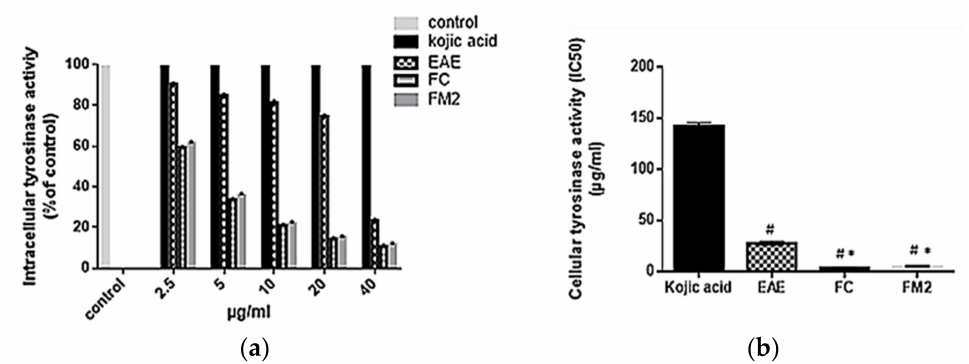
Figure 9. ( a ) Cellular tyrosinase activity (% of control) and ( b ) cellular tyrosinase inhibition activity (IC 50 ) on B16 cells of ethyl acetate extract (EAE), quercetin-3- O -rhamnoside (FC), myricetin-3- O - rhamnoside (FM2), and kojic acid standard (Bars, ± SD ( n = 3)). * Significant p < 0.001 compared to EAE and # significant p < 0.0001 compared to kojic